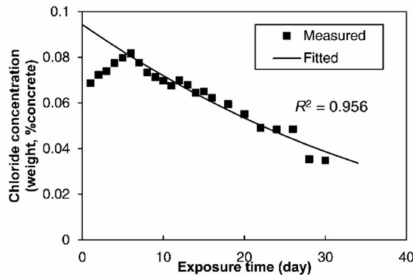
Figure 9. Fitting of The measured chloride profile based on Fick’s equation.